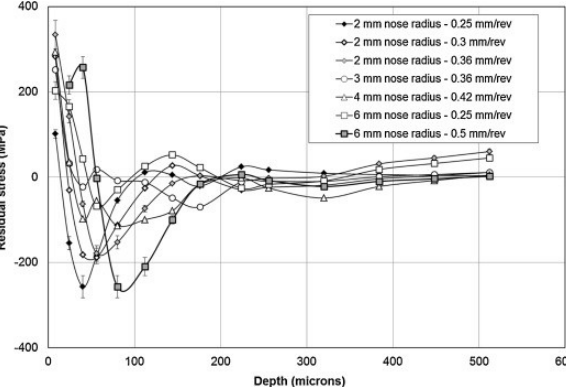
Figure 12: Residual stress profiles of various nose radius values [17]